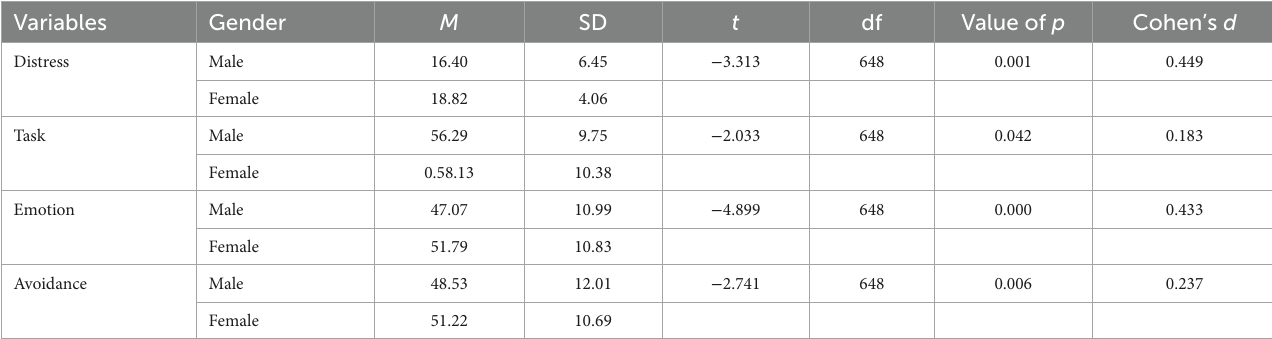
TABLE 1 T-test results of distress and coping differences across gender.